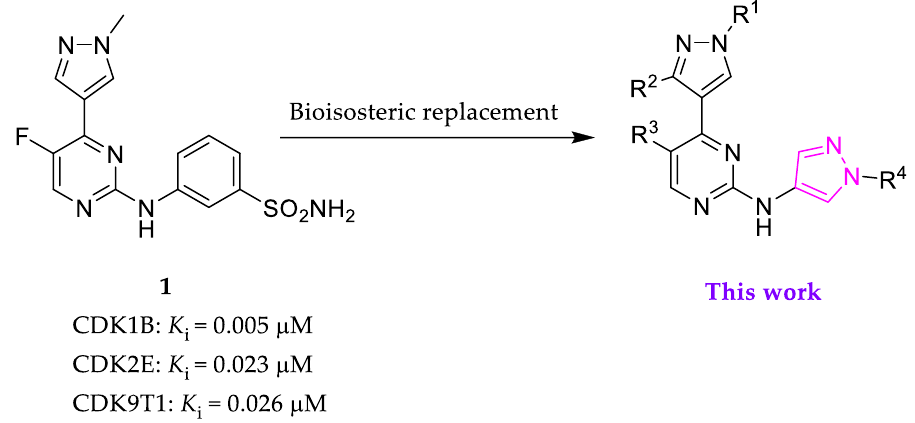
Figure 1. Design of novel CDK2 inhibitors from our previously-identified 1 [20].